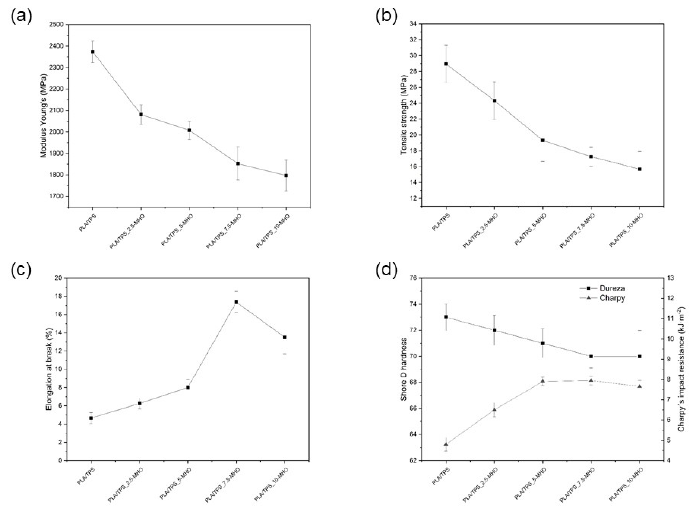
Figure 3. Mechanical properties of PLA/TPS with different percentages of MHO: ( a ) Young ´ s modulus, ( b ) tensile strength, ( c ) elongation at break, ( d ) Shore D impact and Charpy ´ s impact re- sistance.